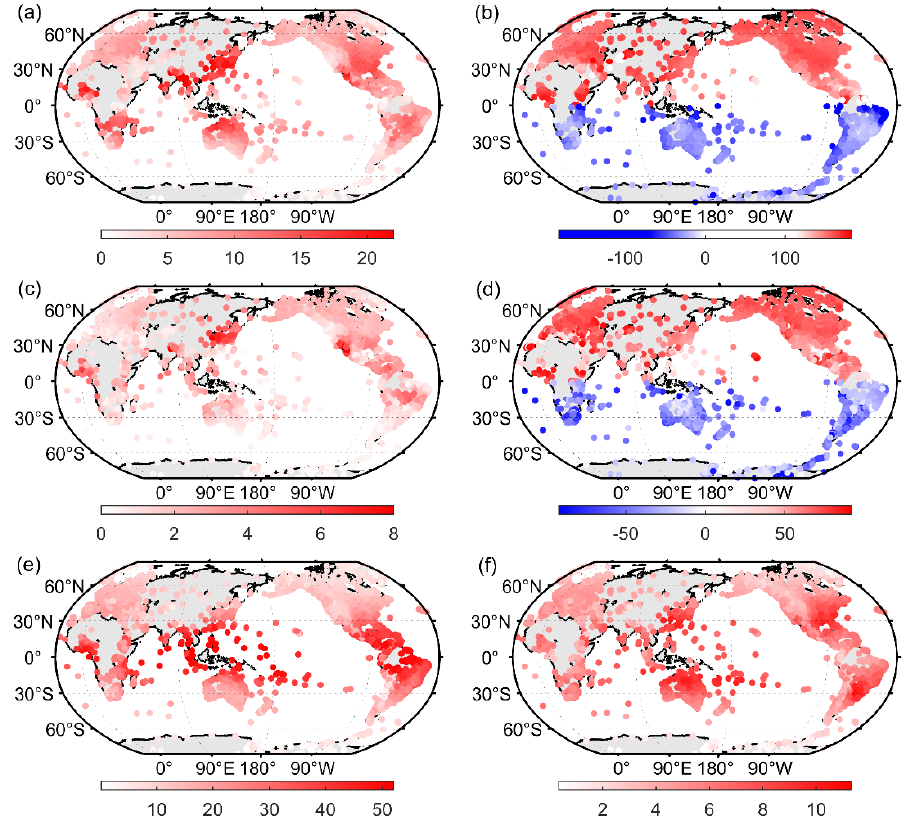
Figure 7. Global distribution of PWV fitting parameters and residuals. ( a ) Annual amplitude A 1 ; ( b ) annual phase P 1 ; ( c ) semiannual amplitude A 2 ; ( d ) semiannual phase P 2 ; ( e ) constant term C ; ( f ) RMSE of the fitting